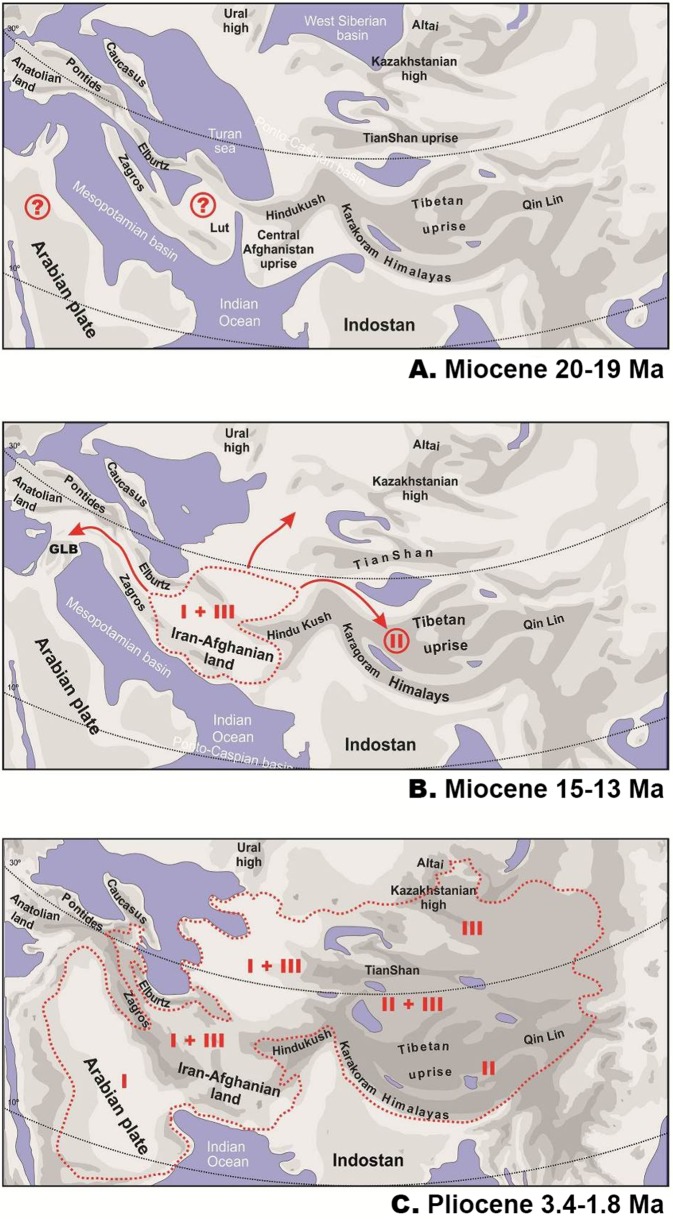
Paleogeography of Paratethys basin in late Cenozoic and the hypothetical scenario for Phrynocephalus.Paleogeographic reconstructions are based on Rögl (1999); Popov et al. (2004); Popov et al. (2009) for early (A) and middle (B) Miocene and Pliocene (C). Question marks denote possible areas of distribution of the common ancestor of Phrynocephalus. GLB—”Gomphotherium-landbridge” between Arabian plate and Asian mainland (18–17 Ma). Red dotted line—possible range of Phrynocephalus; red arrows—possible dispersal routes; Latin numbers correspond to hypothetical distribution of main Phrynocephalus Clades I–III (see Discussion).